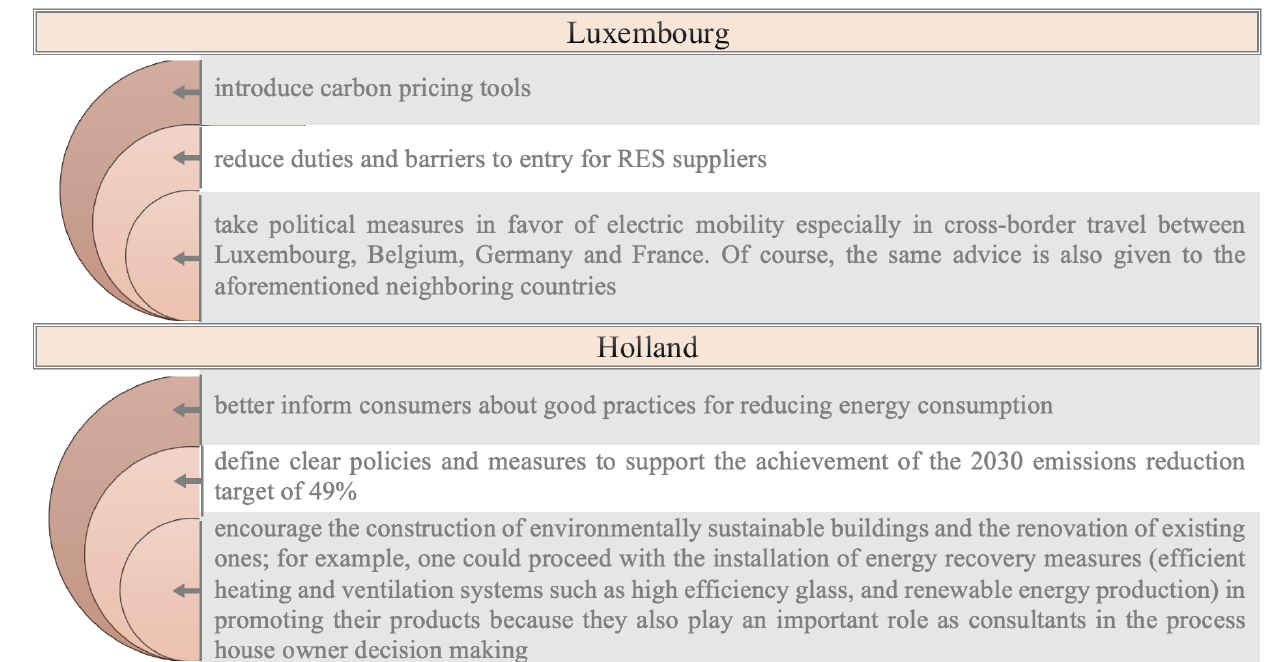
Figure 18. Luxembourg and Holland: final recommendations and implications.